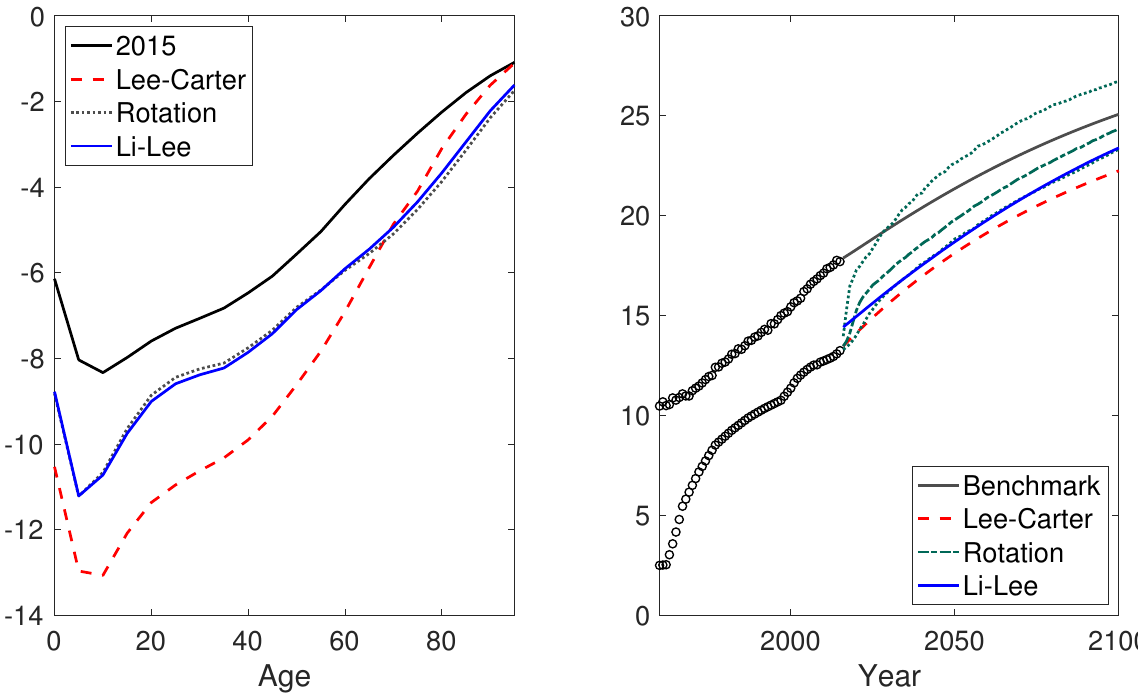
Figure 5. The projected logarithm age-specific death rates ( left panel ) and the remaining life expectancy at 65 ( right panel ) of the average of the benchmark countries and China using different models. For the rotation algorithm, the 2.5%, 50%, and 97.5% quantile of the projected e 65 are